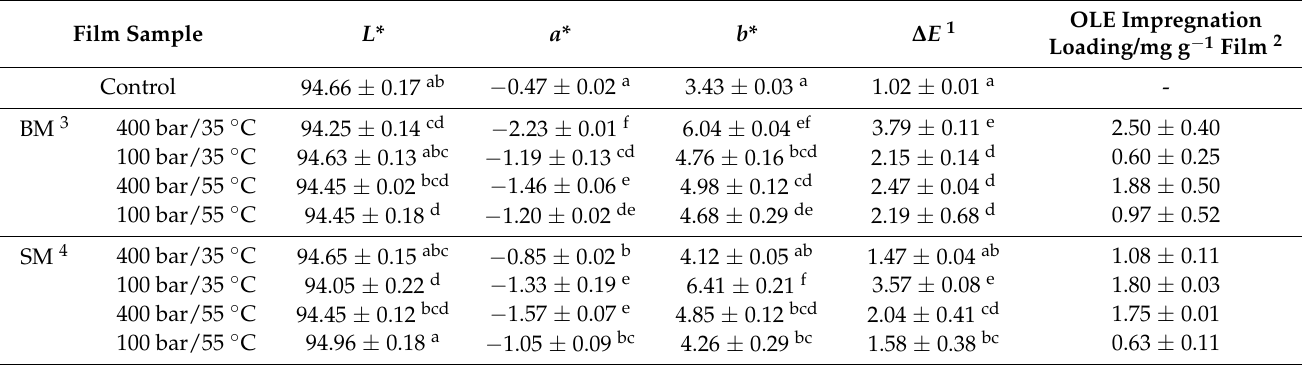
Table 1. L * a * b * c olour characteristics and OLE impregnation loading of PET/PP films prepared under different operational